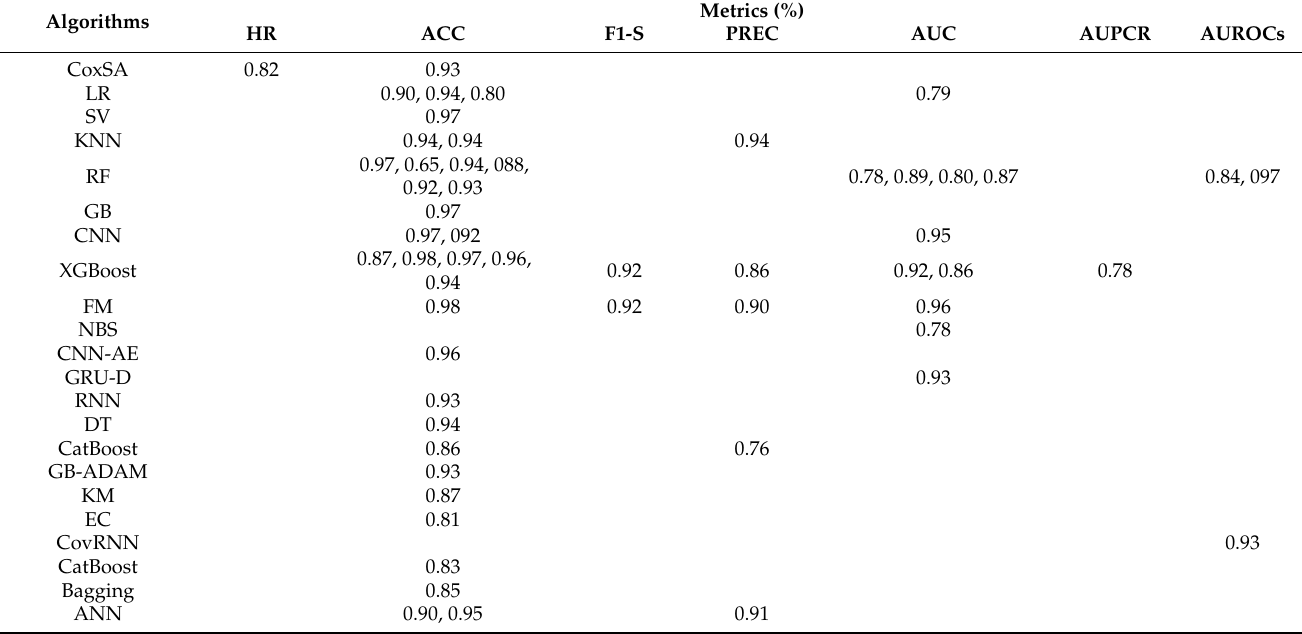
Table 6. Algorithm performance based on the evaluation of the best-performing metrics within the observed